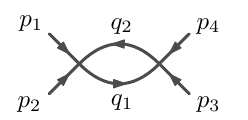
Figure 7. Bubble Feynman diagram used in Ex. 21 and